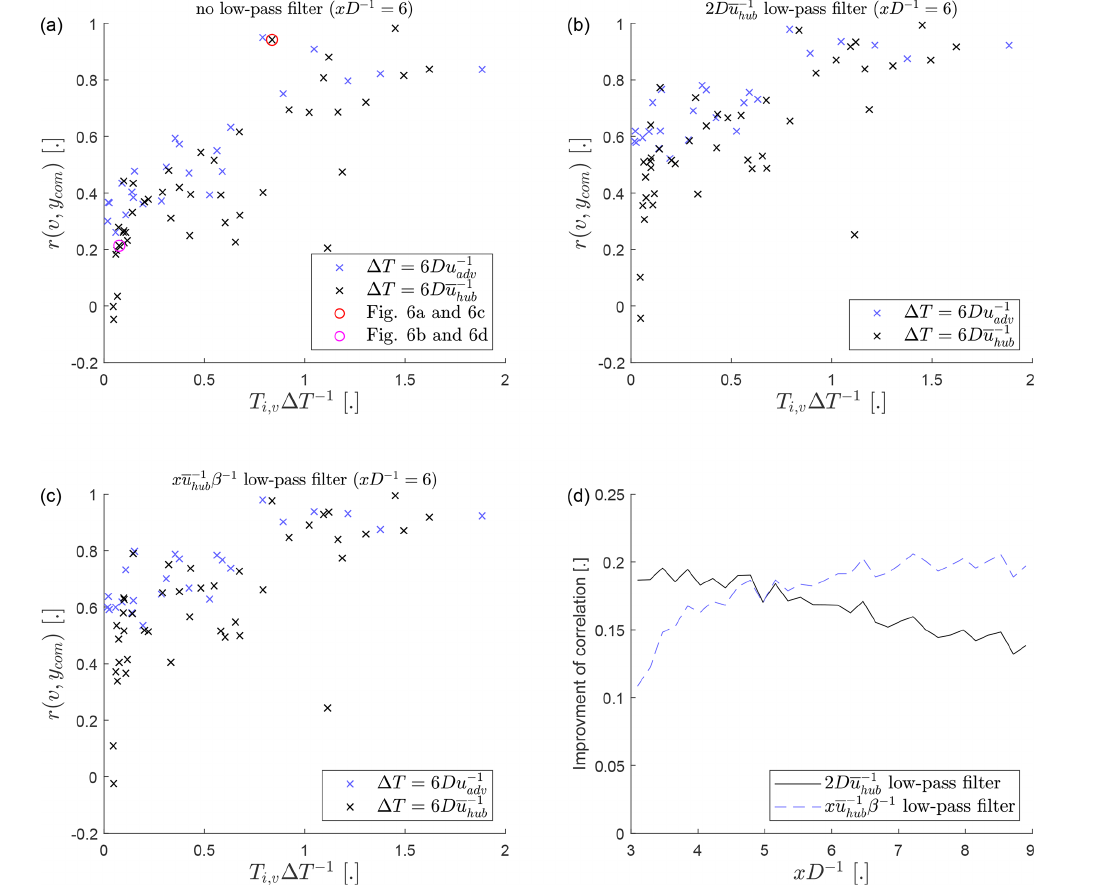
Figure 5. The correlation coefficient between the time-shifted lateral velocity and the wake centre position ( r ( v,y com )) without low-pass (b) , and with low-pass filtering by a moving mean filtering (a) , with low-pass filtering by a moving mean with a window width of 2 Du − 1 hub β − 1 (c) . Data points using a time delay based on the mean wind speed are shown with black crosses, and with a window width of xu − 1 hub data points using a time delay based on the maximized cross-correlation are shown with blue crosses (see Sect. 2.4). The bottom right panel (d) shows the ensemble-averaged improvement of the correlation with low-pass filtering compared to the unfiltered correlation coefficient as a function of the downstream